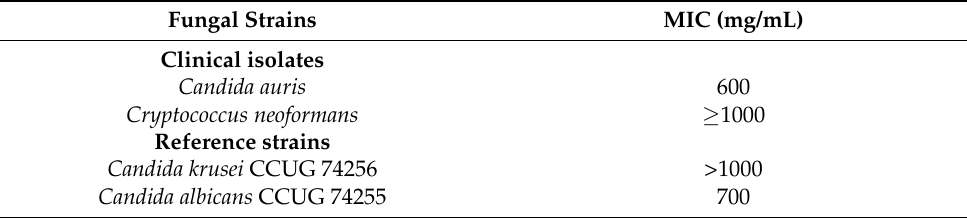
Table 2. Minimum Inhibitory Concentration (MIC) of Sumra honey against various fungal strains including clinical